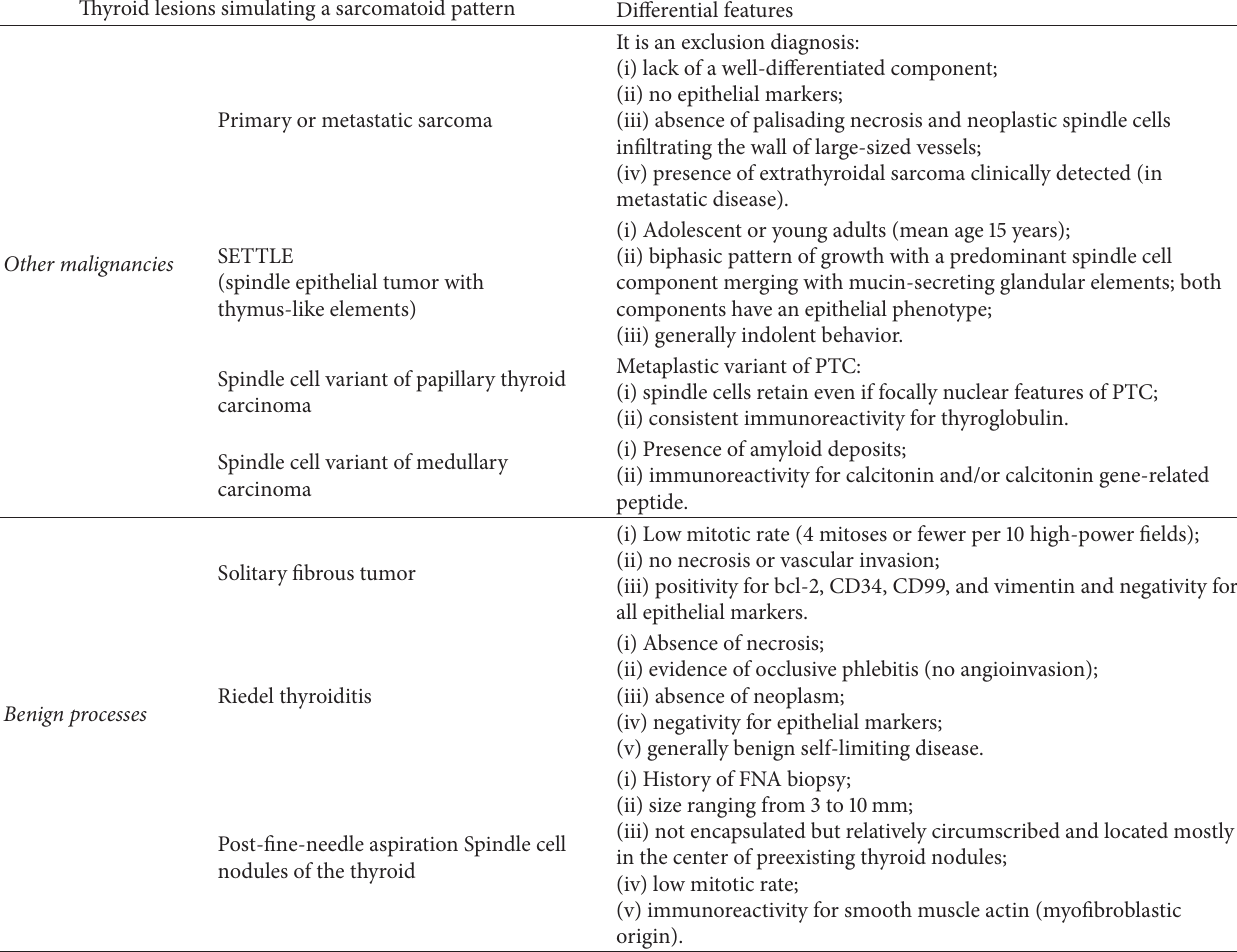
Table 1: Differential diagnoses of sarcomatoid